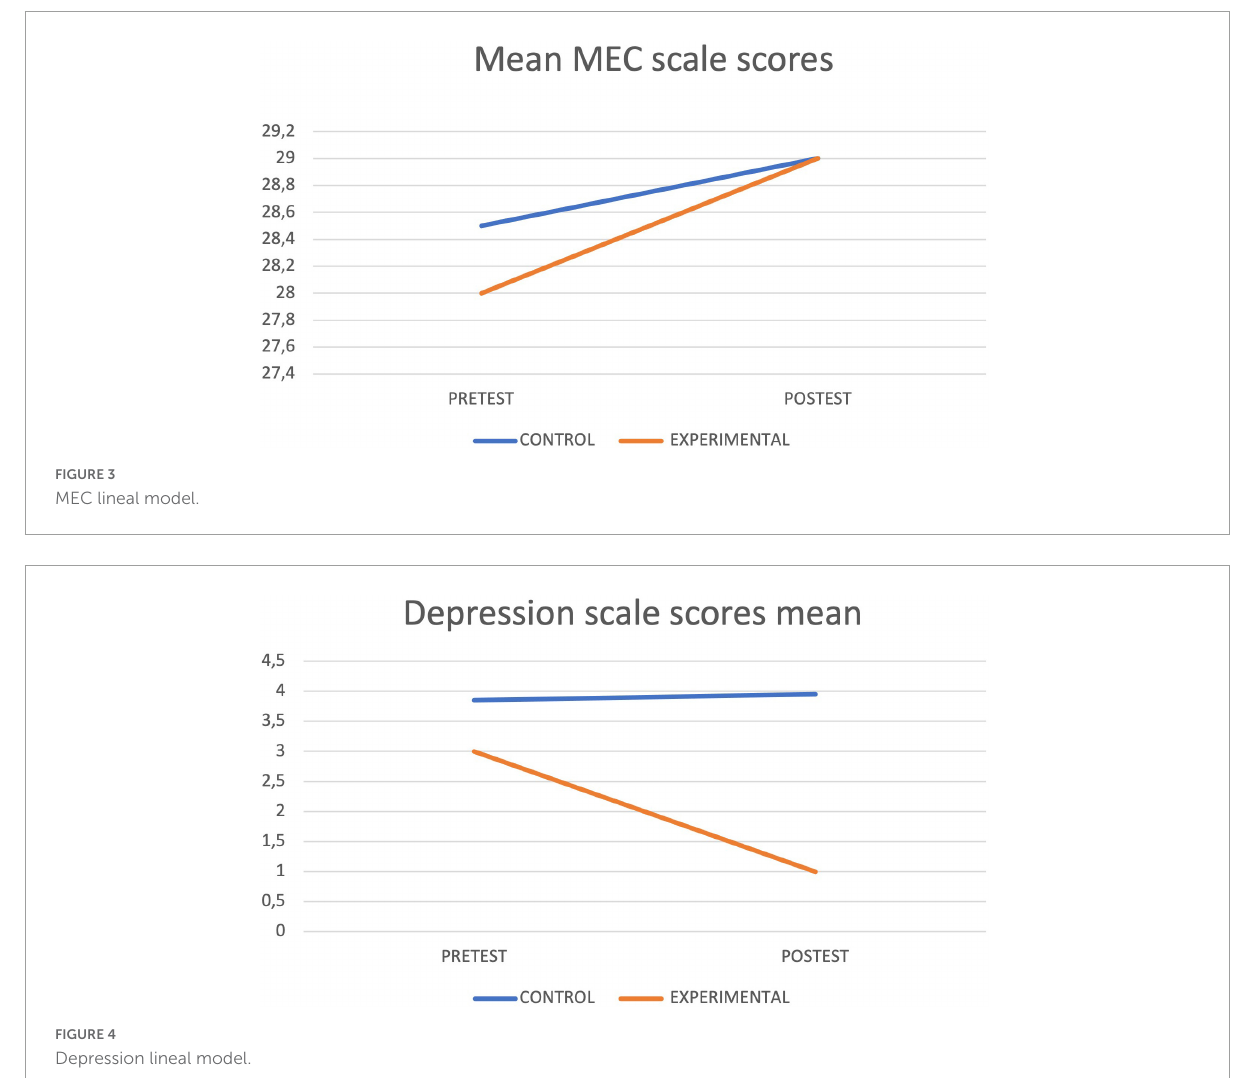
FIGURE4 Depression lineal